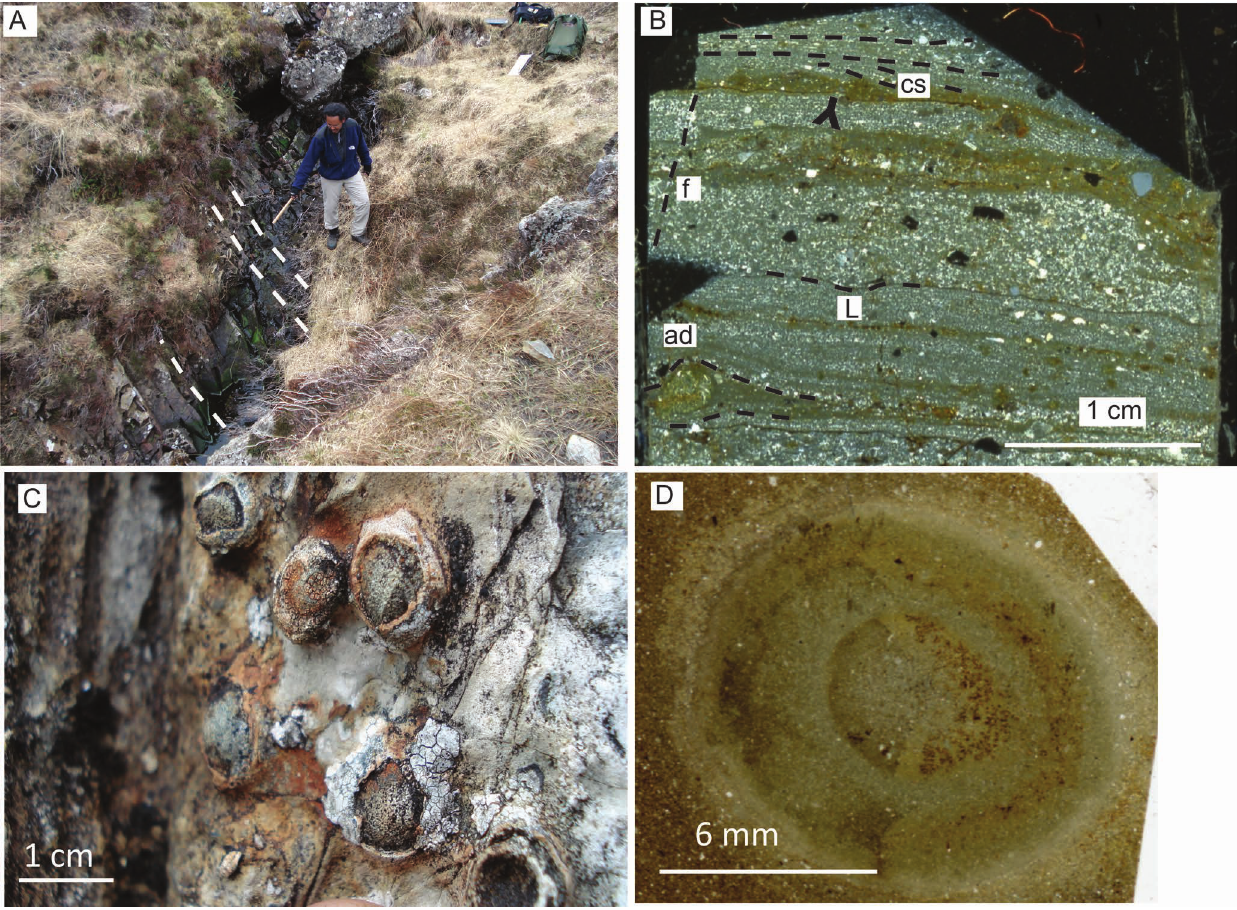
Figure 5: Field and petrographic characteristics of stratified tuff (sT) and accretionary lapilli bearing massive lapilli tuff (mLTacc). [A] Columnar cooling joints within sT on the west bank of Cnoc nan Uan (log 9, 3 m height, see Supplementary Material 1). Columns are juxtaposed with mLT on east bank and highlight a faulted contact running down the stream. [B] Scan of sT from Cnoc nan Uan in XP, loading structures (L), cross stratification (cs), ash drapes (ad). Offset of layers as a result of faulting (f). [C] Cored accretionary lapilli in mLTacc in discontinuous sublinear trails (log 4, 21 m height, see Supplementary Material 1).